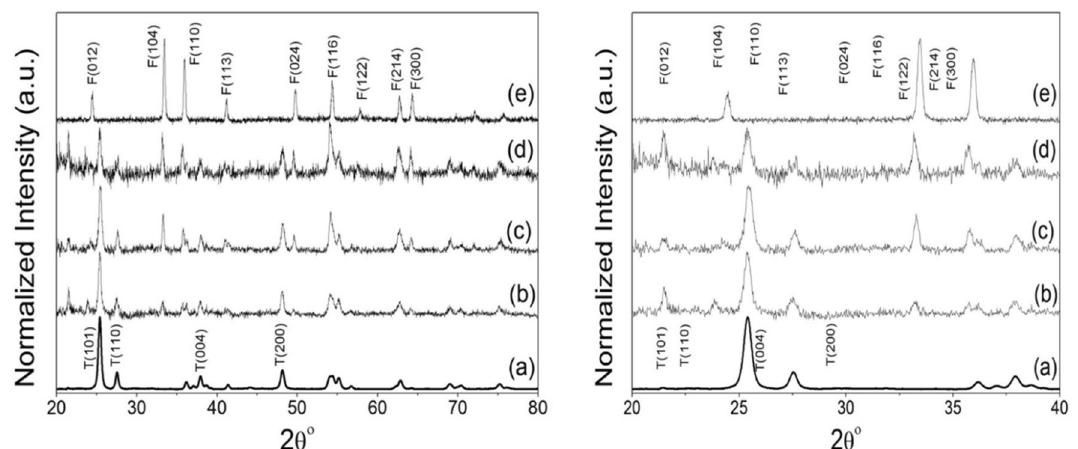
Figure 5. XRD spectra of ( a ) n-TiO 2 , ( b ) 9% n-TiO 2 @α-Fe 2 O 3 , ( c ) 4% n-TiO 2 @α-Fe 2 O 3 , ( d ) 2.3% n-TiO 2 @α- Fe 2 O 3 and ( e ) α-Fe 2 O 3 displayed at full scale (left) and enlarged scale